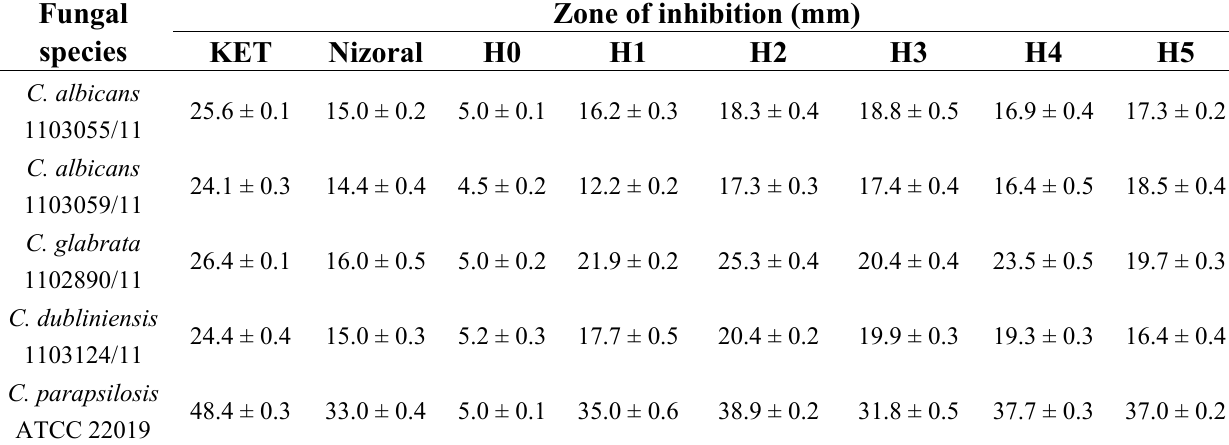
Table 4. Antifungal activity of prepared hydrogels in comparison to reference standard. Fungal